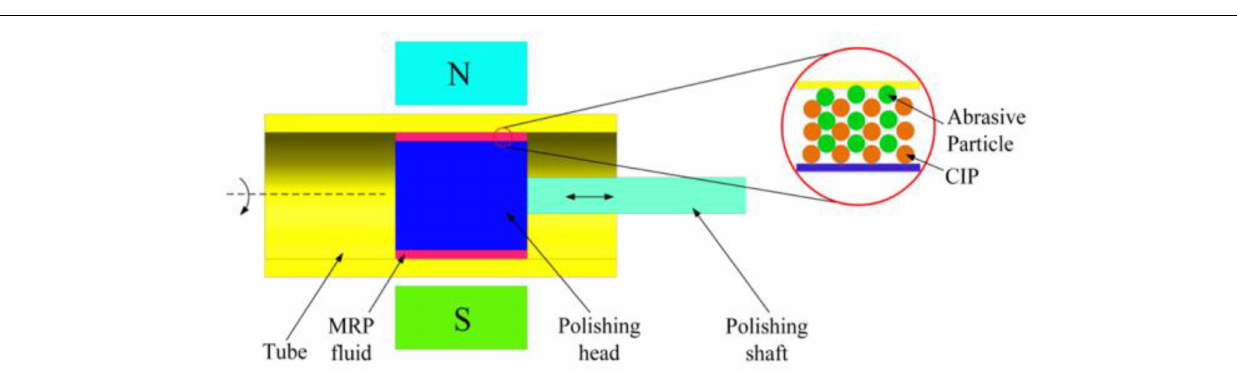
the surface of the heads to process the surface of the workpiece (Bin,